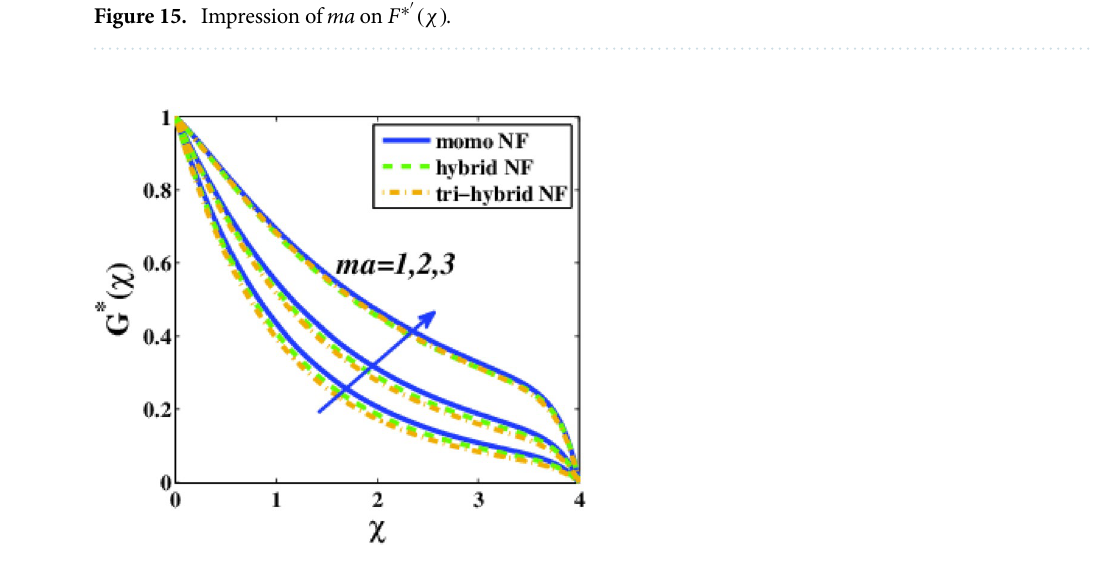
Figure 16. Effect of ma on G ∗ (χ)